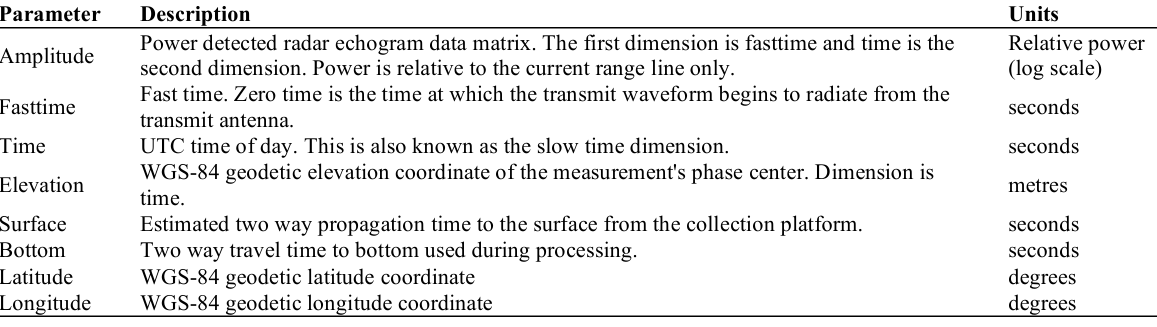
Table 2. File parameter description of IRMCR1B data.